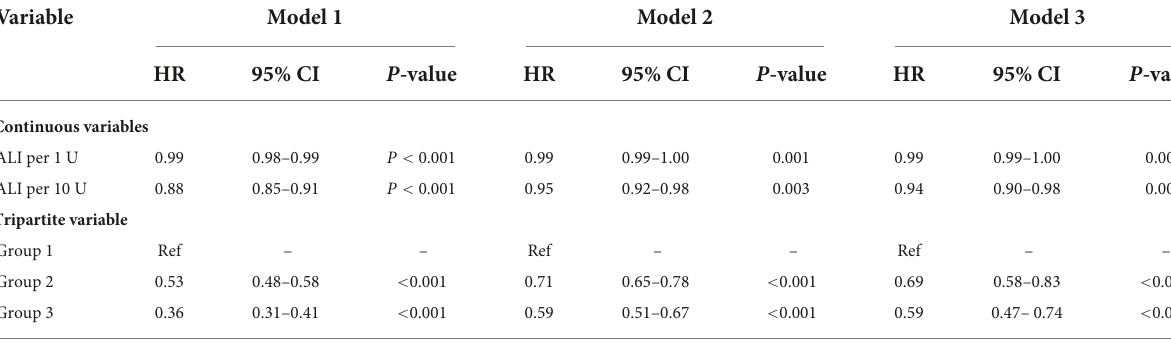
TABLE 2 Associations between advanced lung cancer inflammation index (ALI) and all-cause mortality in NHANES 1999–2014 followed through 2015. Variable